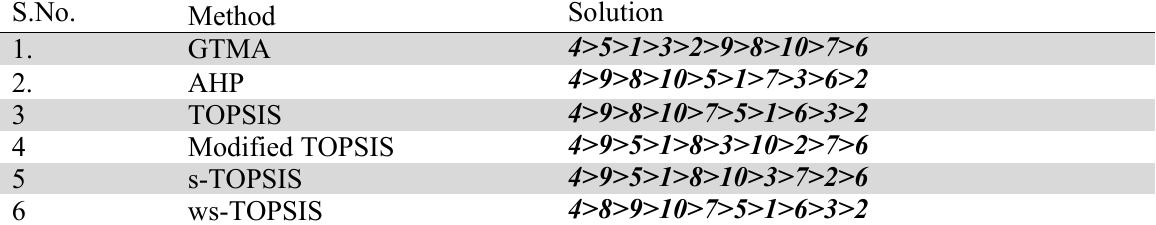
A comparison of the results obtained from different methods